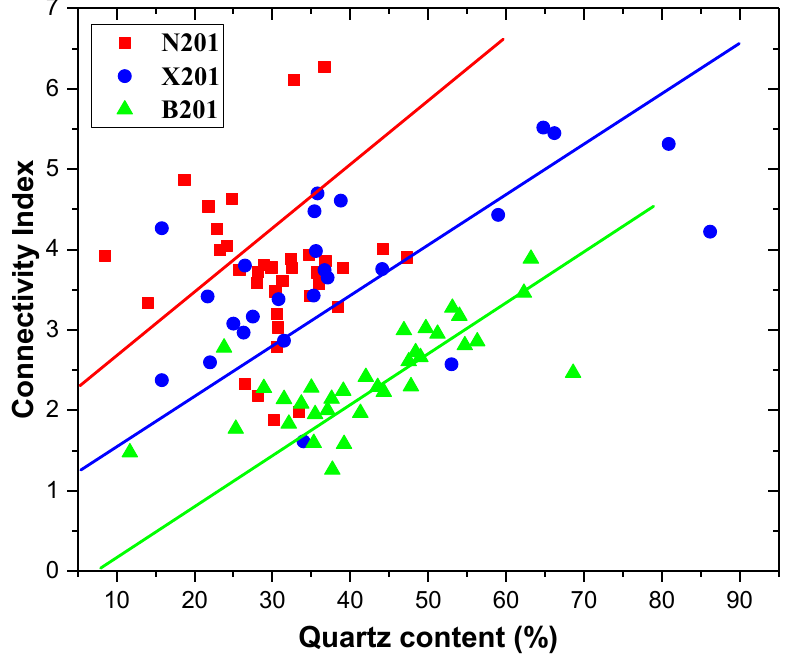
Figure 17. Quartz effect on connectivity index.